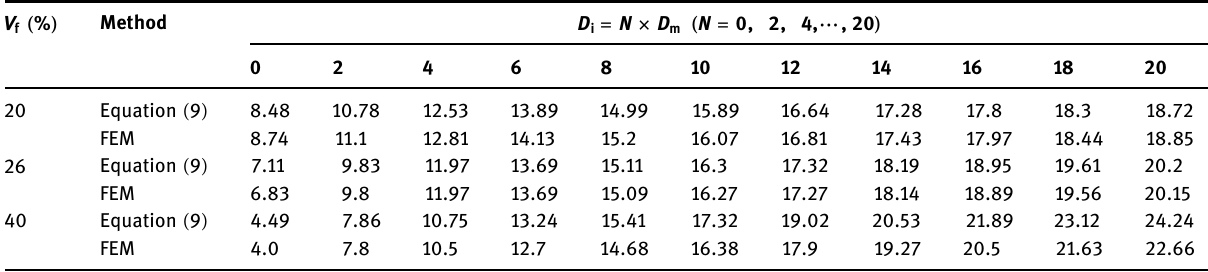
Table 4: Moisture di ff usivities of CF/PA6 laminate interfaces ( D i ) determined using FEM and the modi fi ed Halpin – Tsai equation. Here V f , N , and D m denote the volume fraction of the fi bers, number of fi bers, and di ff usivity of the matrix,